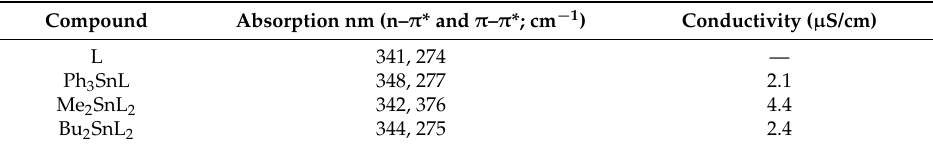
Table 3. Electronic spectral data and conductivity for L and its organotin(IV) complexes.